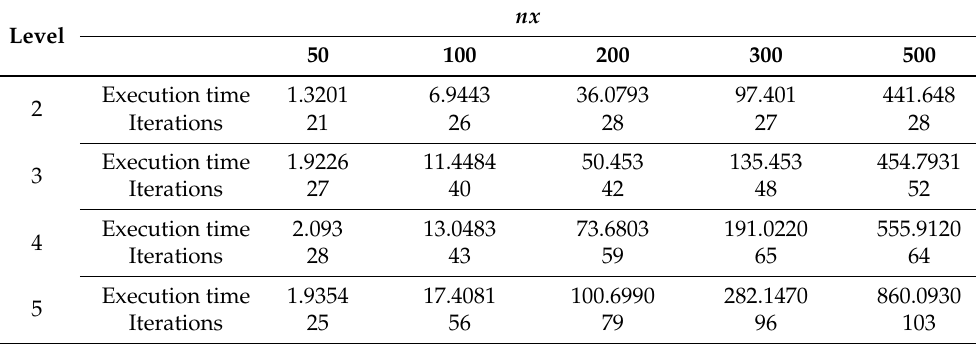
Table 5. Convergence behavior and performance of V cycle of AGAMG in combination with deflation technique and MGenFAspI with droptol = 0 and l fill = 2 for 2D Poisson model problem.